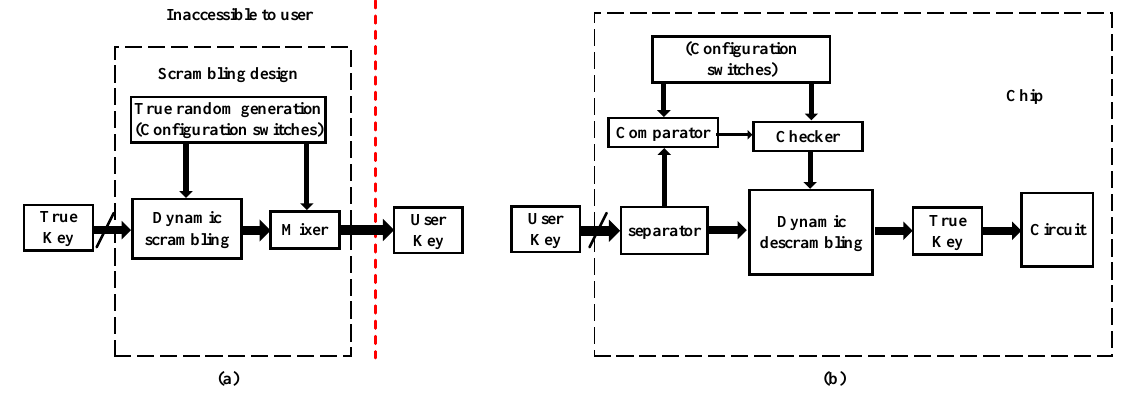
Figure 10. Scrambling technique used for ( a ) scrambling and ( b )